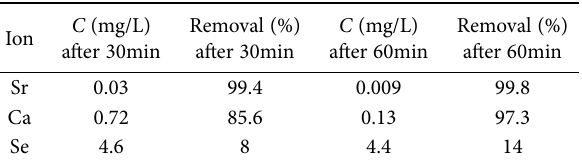
Table 1. Batch ion flotation results using air bubbles with 100mL solutions of 5mg/L each with single solutions of strontium, sele- nium and calcium ions using crystallised N-octanoyl-cys sur- factant. The batch process started with a surfactant concentration, C surfactant =0.01M and was maintained a pH=8.